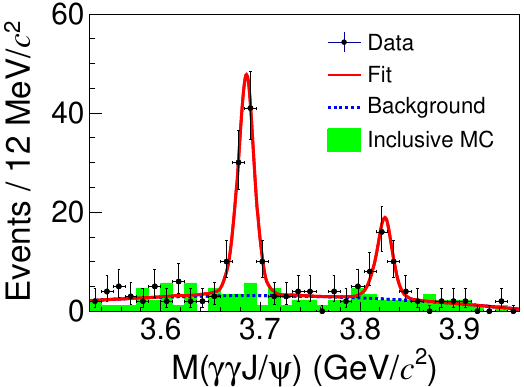
√ s = 4 . 23 to 4 . 70 GeV. The